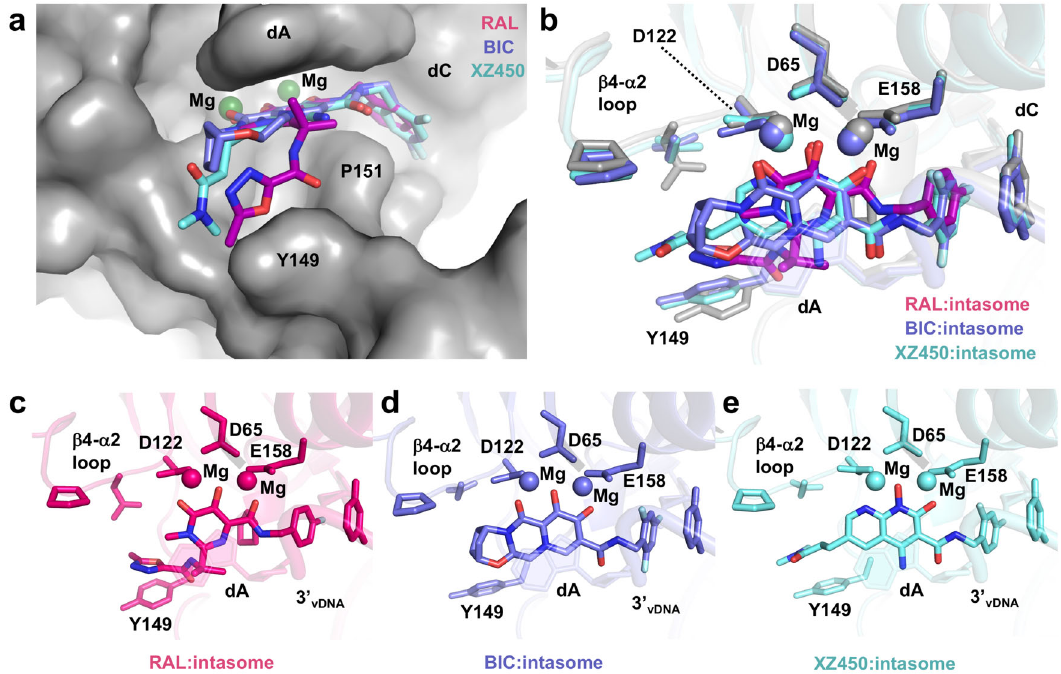
Fig. 4 STLV-1 intasome:INSTI complex structures. a View of the active site with the three INSTI structures overlaid binding to the STLV-1 intasome. Magnesium ions are coloured green. For clarity, the true positioning of the INSTIs is shown in the context of the intasome:RAL complex structure only (grey) which is shown in surface view ( a ) and sticks ( b ). c – e Active sites of all three complete intasome:INSTI complex structures are shown in cartoon with side chains as sticks. Magnesium ions are coloured according to the colour of the rest of the model. The drugs are shown as sticks, with the carbon atoms of RAL in magenta, BIC in purple and XZ450 in cyan. dA, deoxyadenosine; dC, deoxycytidine; RAL, raltegravir; BIC, bictegravir. NATURE COMMUNICATIONS| (2021)